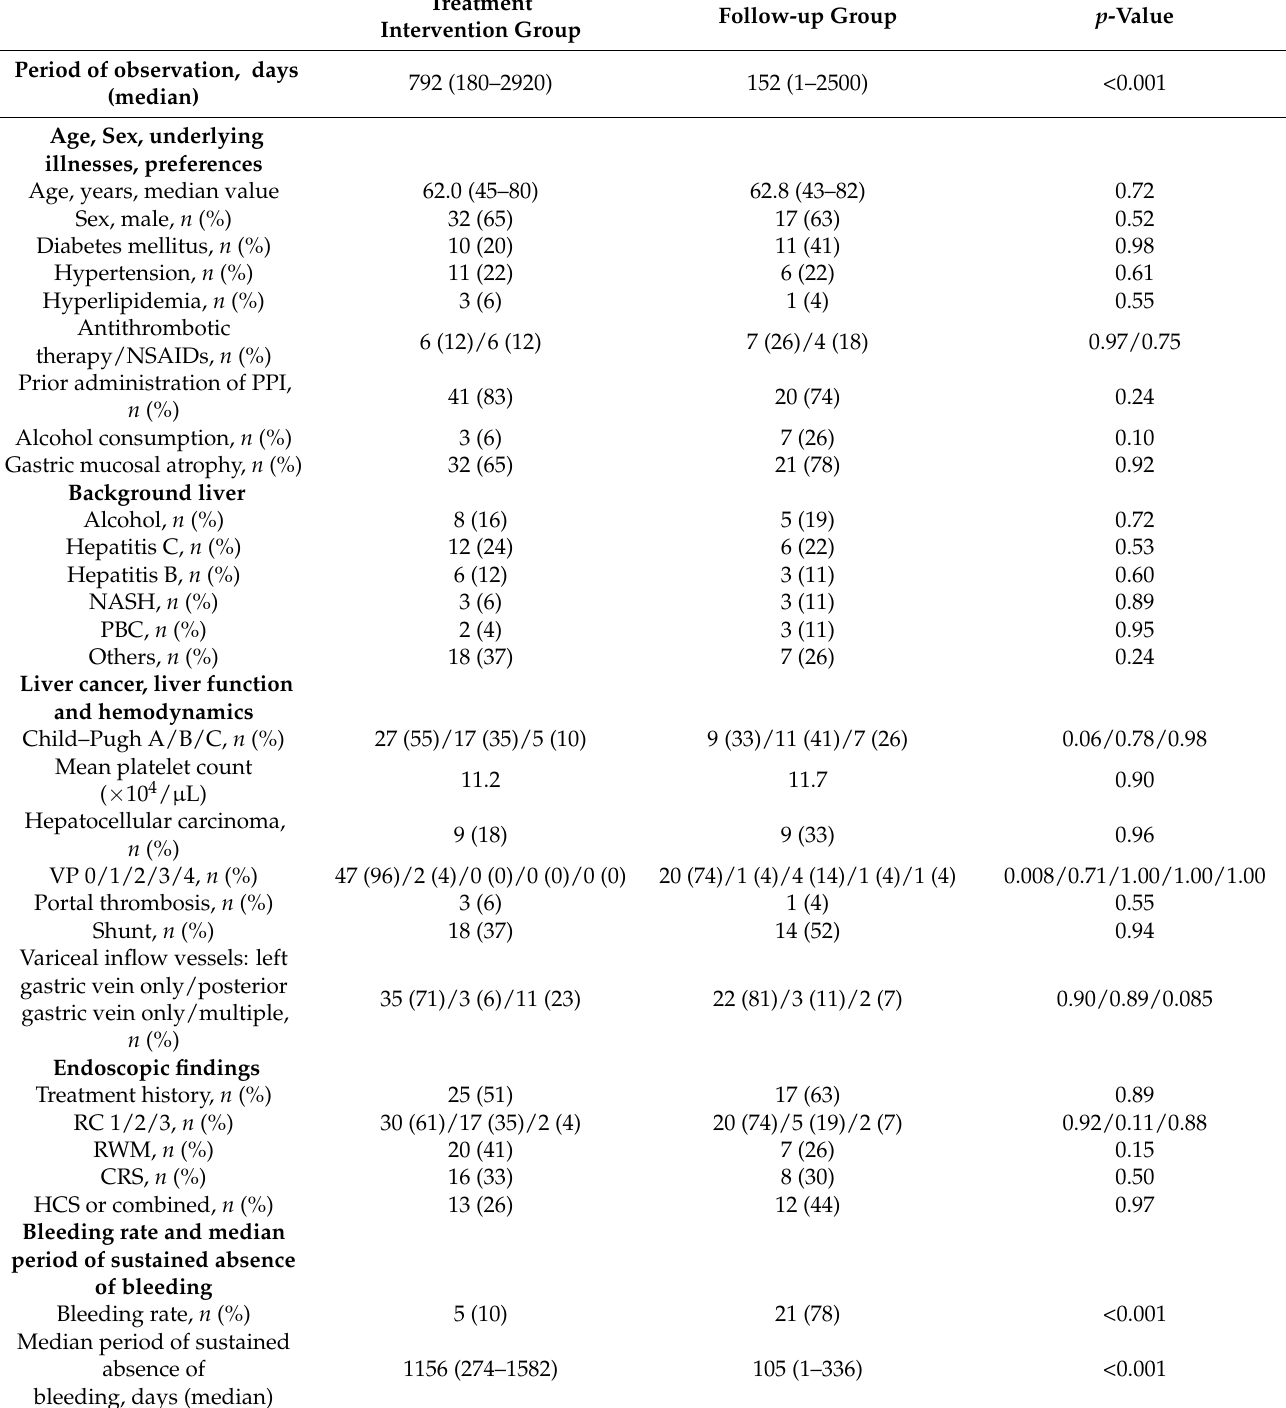
Table 2. Patient characteristics: Treatment intervention group ( n = 49) and follow-up group ( n = 27). Treatment Follow-up Group p Intervention Group